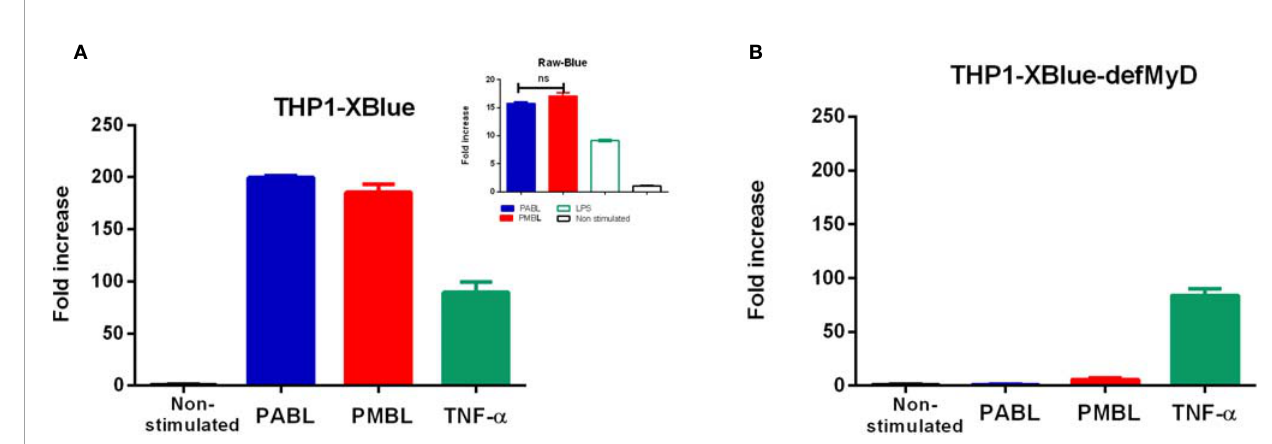
FIGURE 1 | THP1-Xblue (A) , RAW-Blue (A , inset) and THP1-XBlue-DefMyD (B) cells were in vitro stimulated for 24 h with PABL or PMBL (10 mg/ml). TNF- a (50 ng/ml) was used as a control of activation in MyD88-de fi cient cells. LPS (1 m g/ml) was used as a control of activation of RAW-Blue cells. SEAP reporter was quanti fi ed in culture supernatants by optical density readings at 638 nm using the QUANTI-Blue method. The bars represents Mean ± SEM of triplicate cultures for relative increments of stimulated cells related to non-stimulated ones. Data are representative of three independent experiments. ns, non-signi fi cant